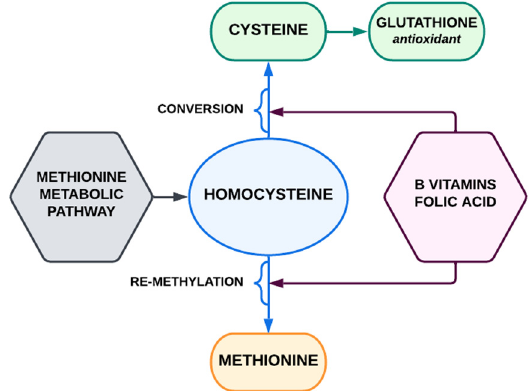
Figure 2. Methionine metabolic pathway (simplified).